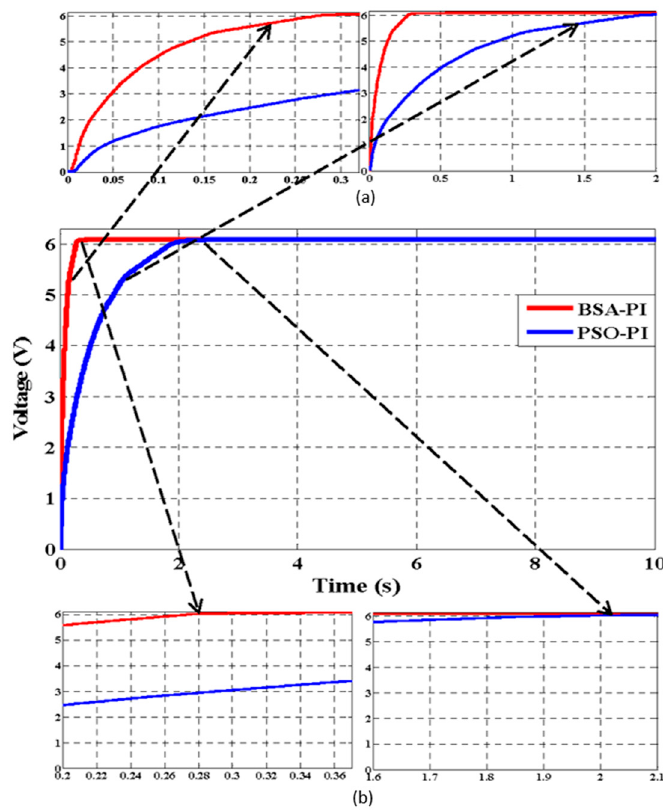
Figure 12. Simulation results BSA-PI and PSO-PI controller with respect to rise time ( a ) and settling time ( b ).